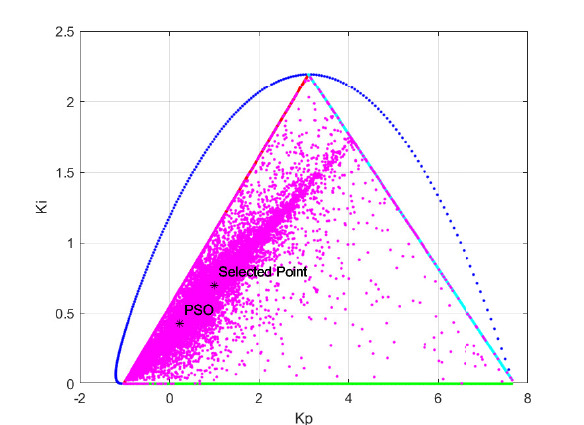
Figure 11. Stability region for Example 2